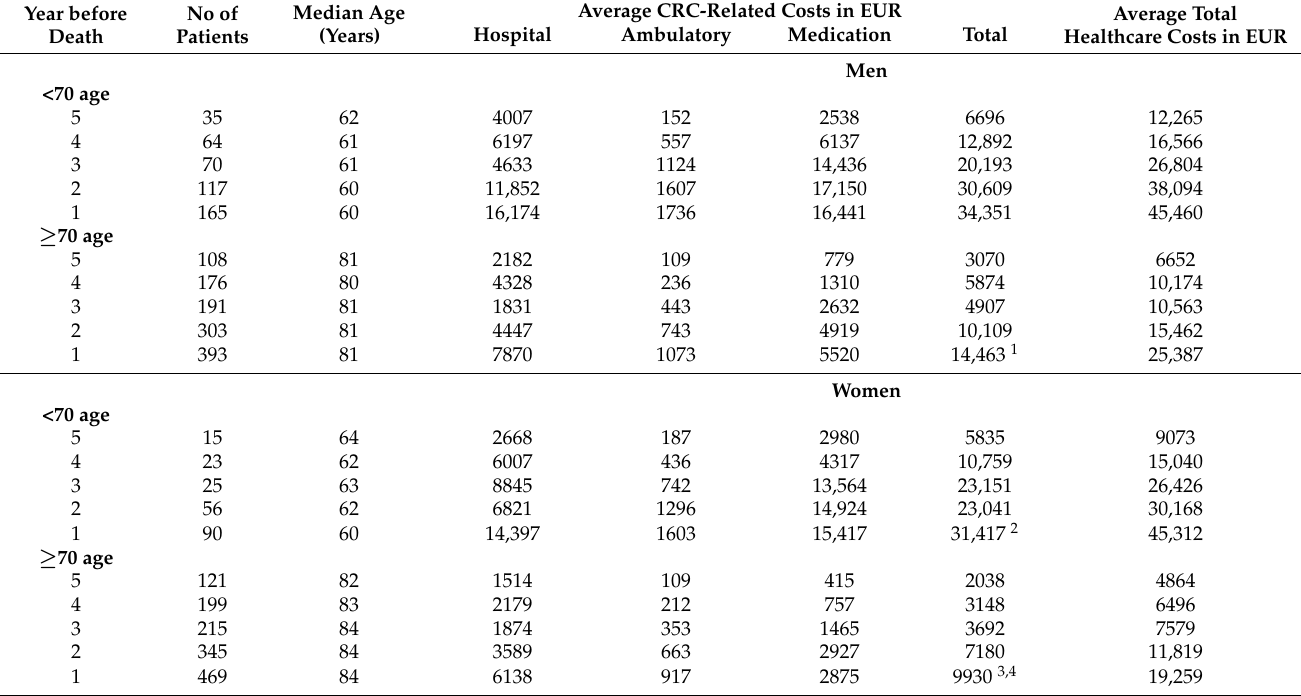
Table 2. Inpatient, outpatient and medication costs 1–5 years prior to death, stratified by sex and